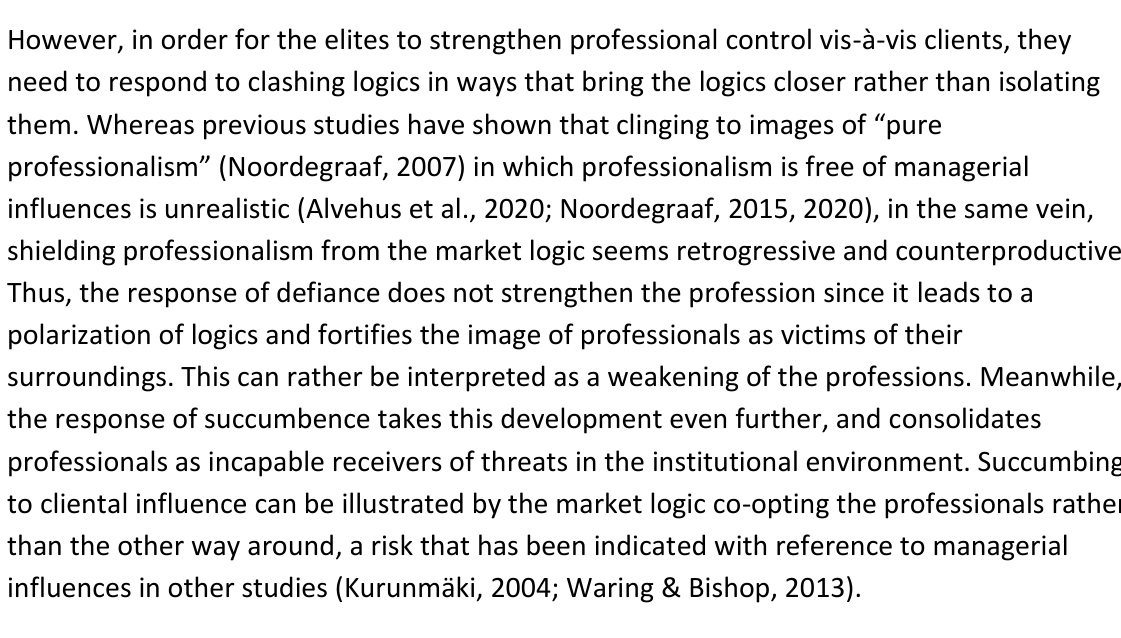
Table 2 sums up the effects of the different responses on the logics and on the